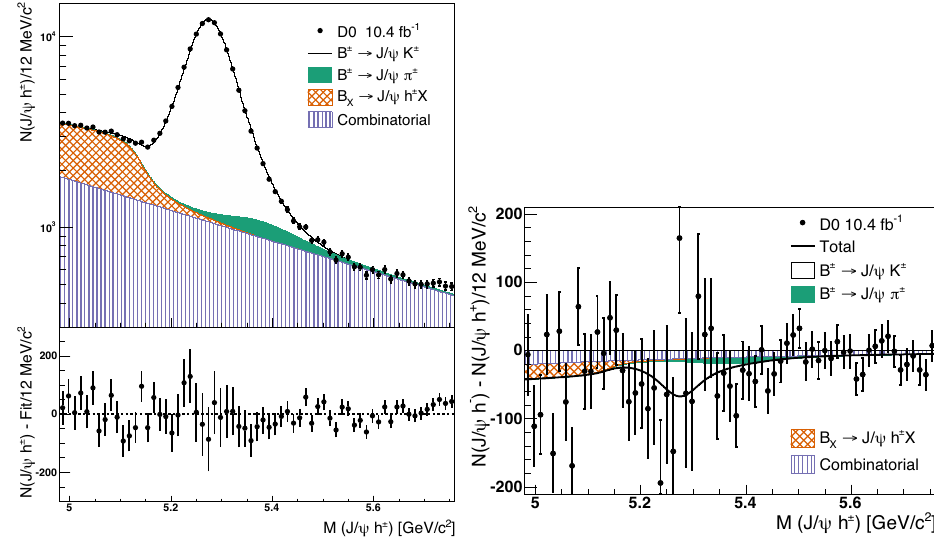
Figure 10. Measurement of CP violation asymmetries in B -meson decays at DZero.